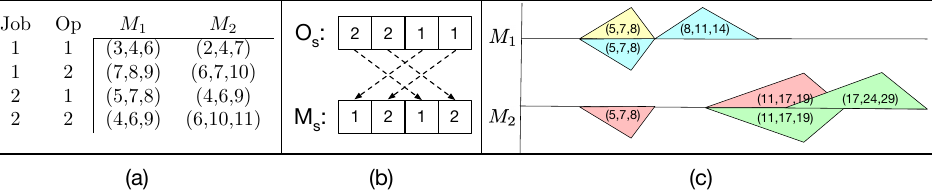
Figure 1. FFJSSP example. ( a ) Description of the problem and the fuzzy processing times. ( b ) Decod- ing of the O s and M s sequences. ( c ) Fuzzy Gantt chart corresponding to the solution specified by O s and M s